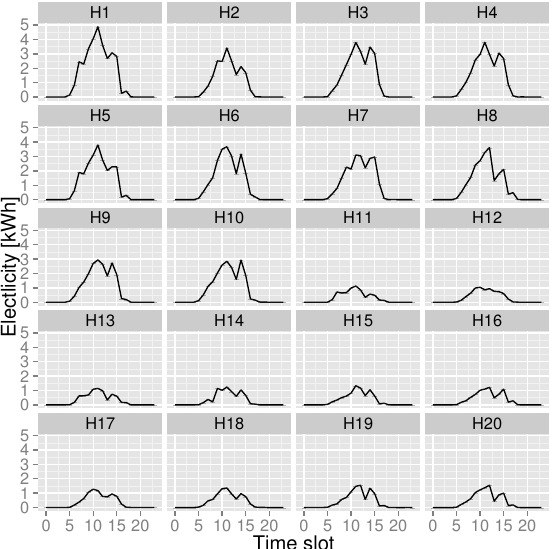
Figure 4. Amount of power generated l t − , max